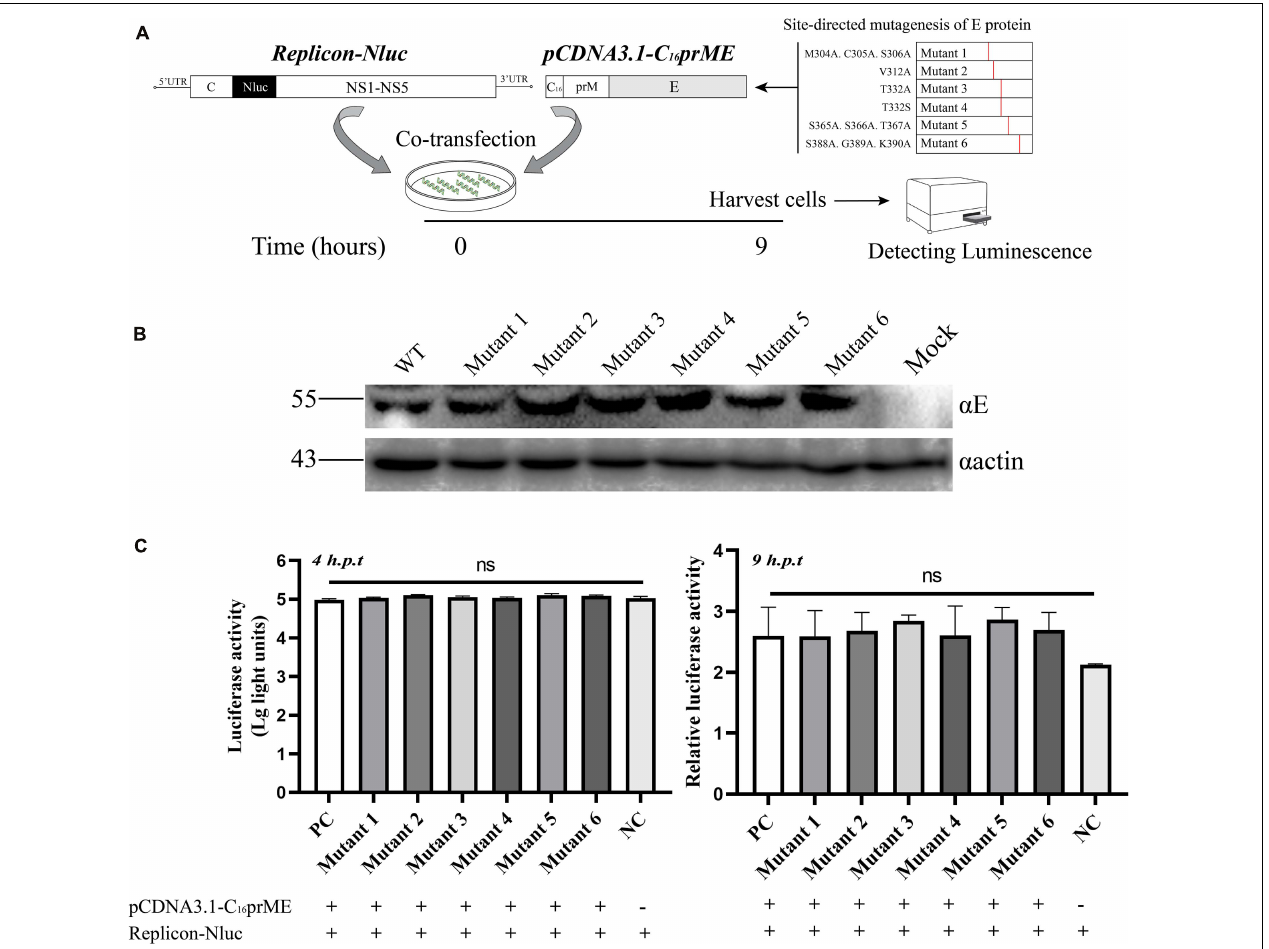
FIGURE 4 | The effects of the structure protein with E mutations on viral RNA replication using Tembusu virus (TMUV) replicon system. (A) Schematic diagram for the replication assay. (B) BHK-21 cells were transfected with wild-type (WT) or mutant packaging plasmid. Cells were harvested for Western blot (WB) at 18 h post-transfection (p.t.) with the indicated Abs. (C) Luciferase activities of BHK-21 co-transfected replicon-Nluc and pCDNA3.1-C 16 prME on 4 h p.t. (left panel). The relative luciferase activity is represented by the Nluc level at 9 h p.t. relative to 4 h p.t. The Nluc levels of all mutants are shown as relative ratios to wild type (WT) (right panel). PC: WT pCDNA3.1-C 16 prME, NC: replicon-Nluc only. Means and standard errors are from three independent experiments. ns, no statistically significant difference in viral genome